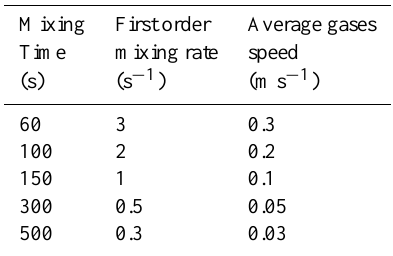
Table 2. Correlation table between mixing time and modeled aver- age speed of gases in the CESAM